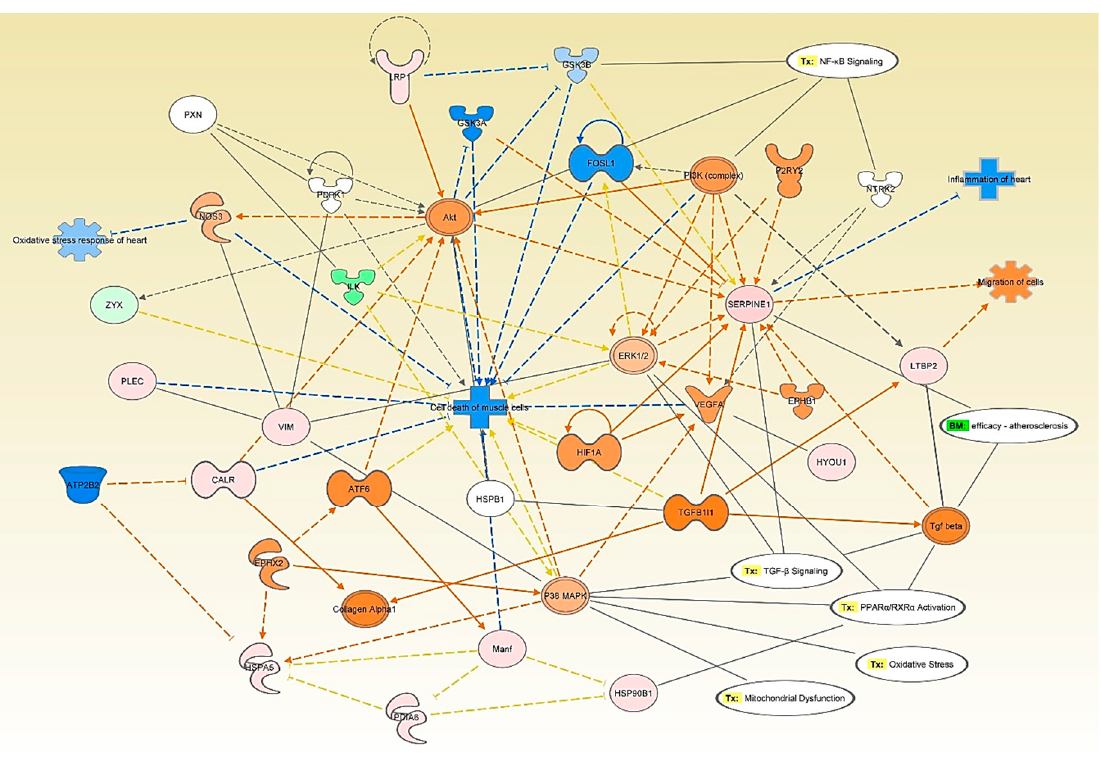
Figure 7. IPA network analysis of the modified proteins in response to leptin 24 h stimulation relative to control in RASMC. The top Tox functions related to the modified proteins are oxidative stress, mitochondrial dysfunction, TGF- β signaling, and NF κ B signaling. Red indicates an upregulated protein, green indicates a down-regulated protein, orange indicates an activated protein, and blue indicates an inhibited protein. The color intensity represents the level of expression.